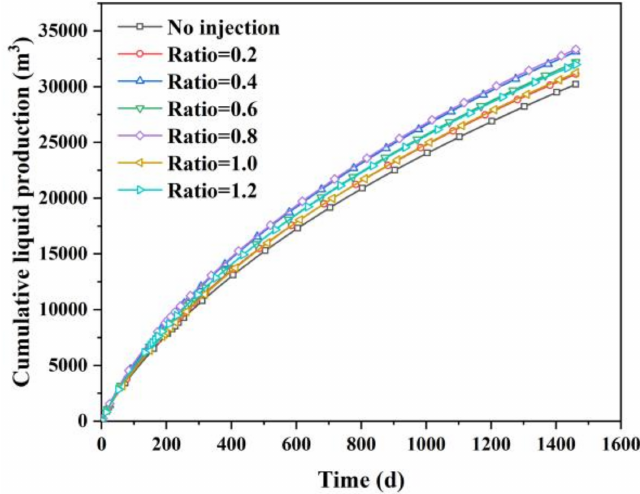
Figure 9. Cumulative liquid production of infill well.